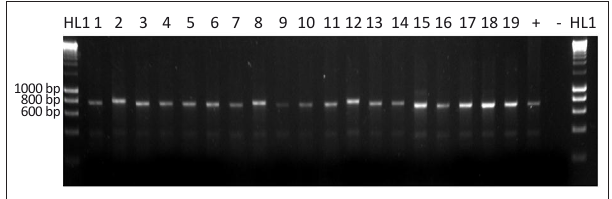
FIGURE 1: Molecular detection and confirmation of Bartonella.